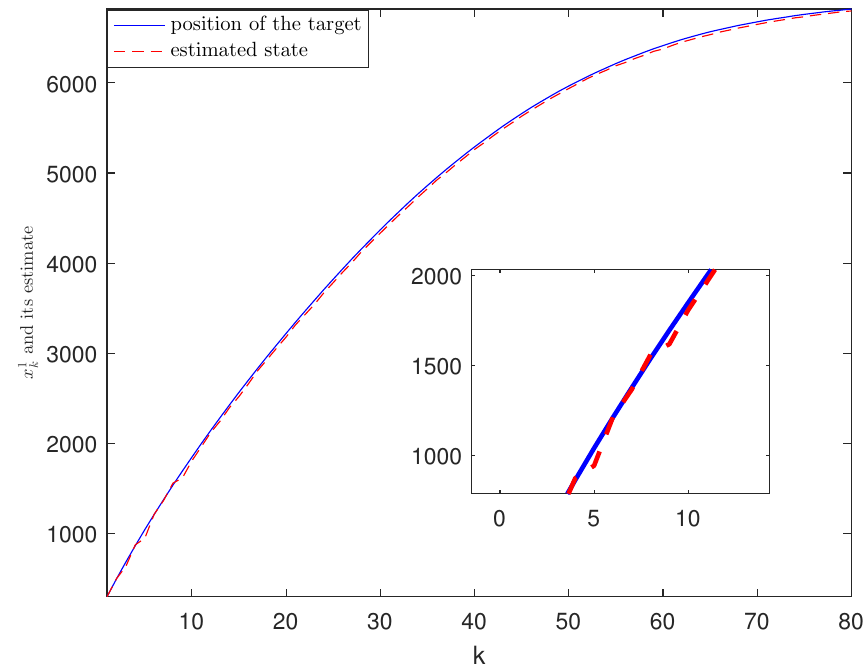
Figure 6. The position of the target x 1, k and its estimate.